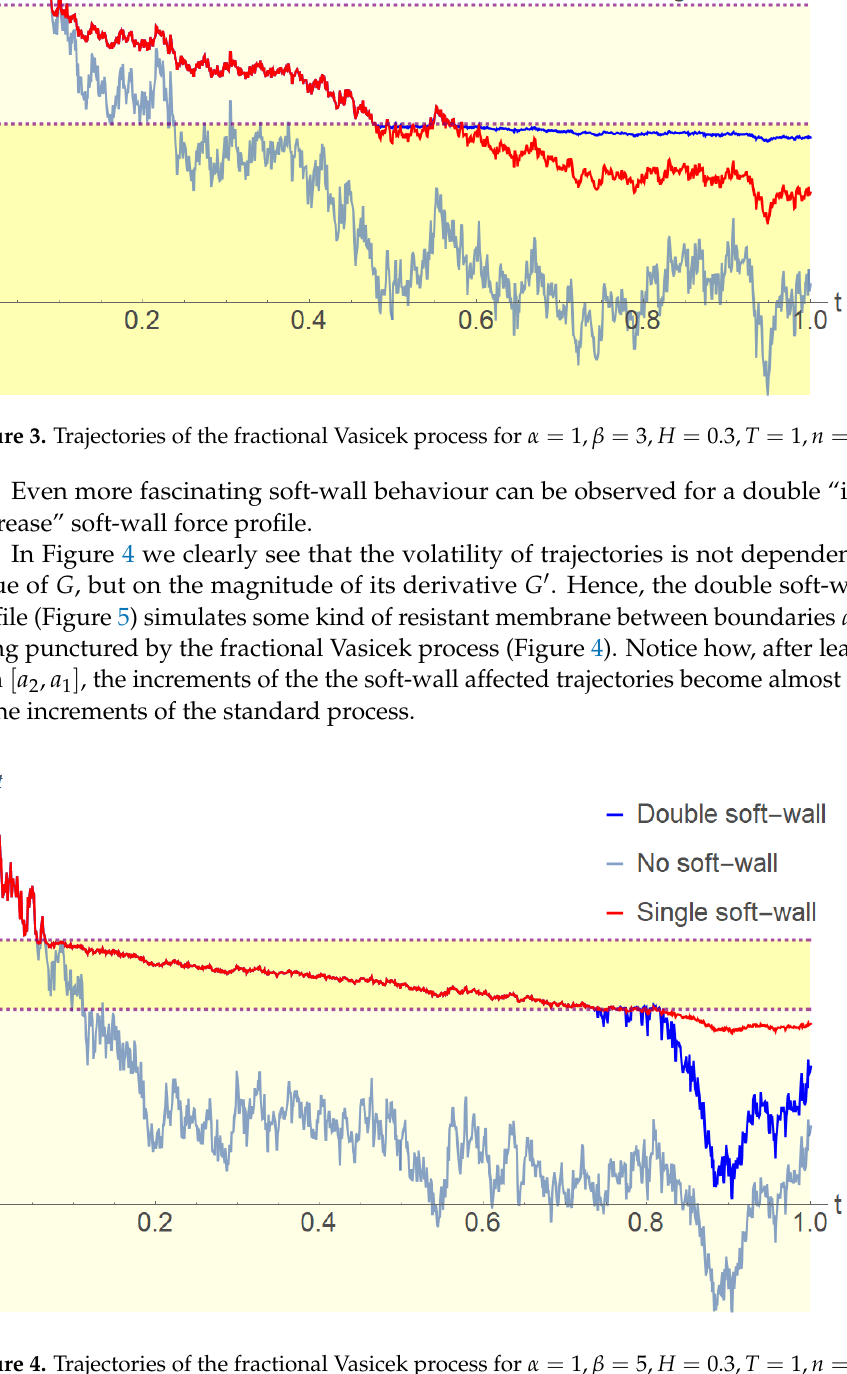
Figure 4. Trajectories of the fractional Vasicek process for α = 1, β = 5, H = 0.3, T = 1, n =